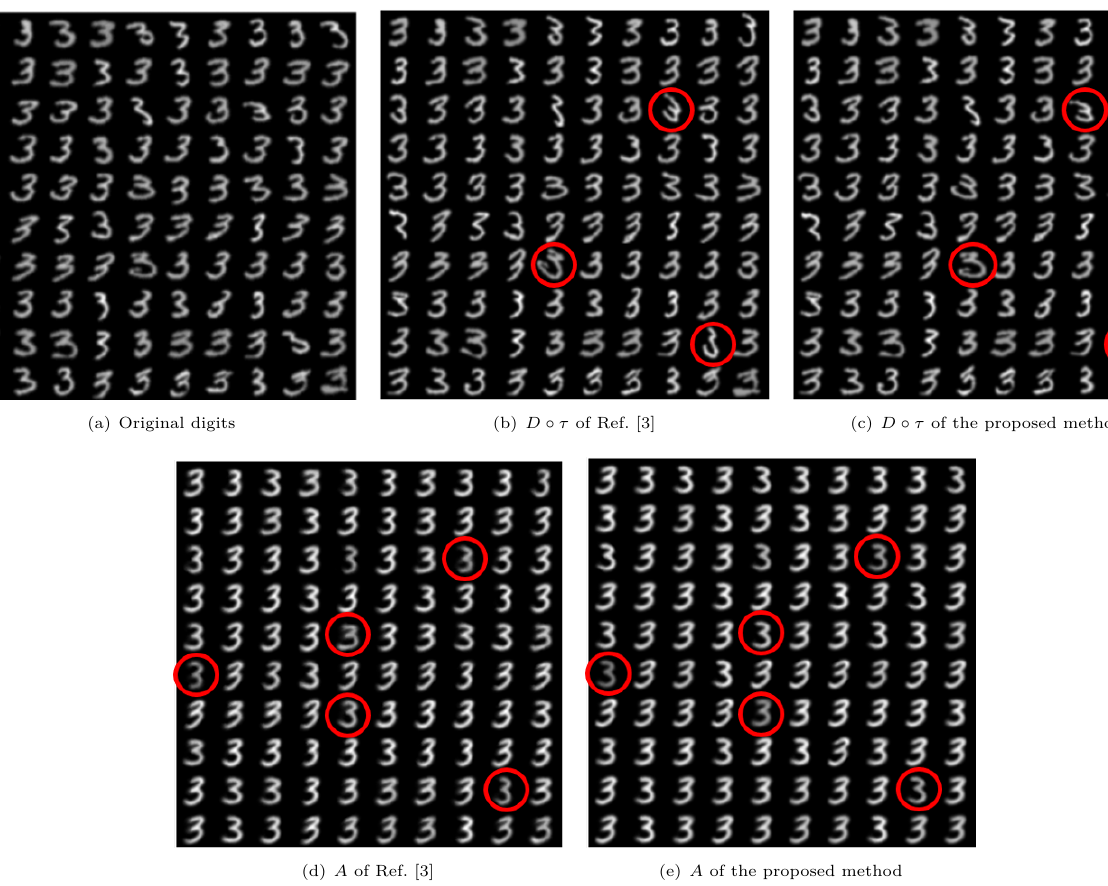
Fig. 6 Experimental results for handwritten “3” digits. (a) 100 original images from MNIST. (b) and (d) were generated by RASL, (c) and (e) by our proposed method. The red circles mark some obvious differences between two method, which support that conclusion that our proposed method is more